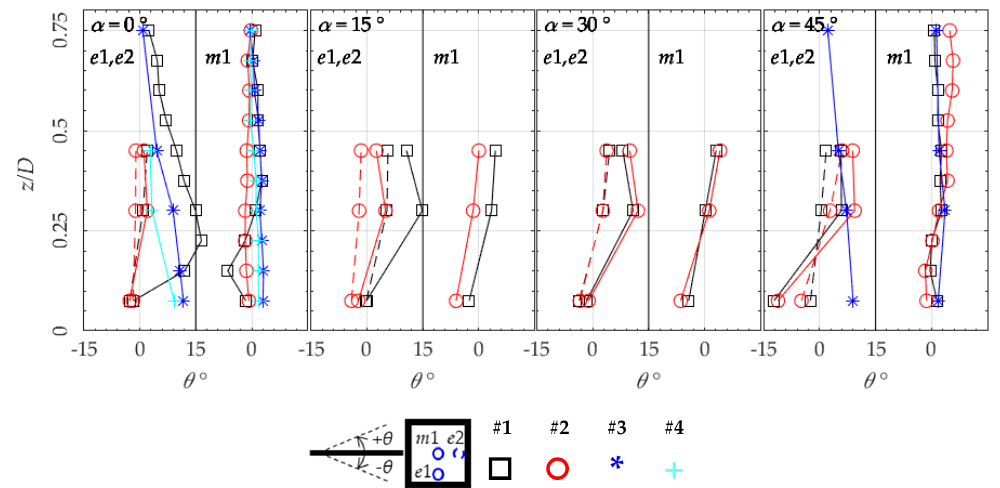
Figure 10. Mean skew angle at windward and leeward edges ( e 1, e 2), and centre location ( m 1). Symbols as indicated in the legend, for configurations #1, #2, #3, and #4 and the four wind directions. Positive values for nose-up skew